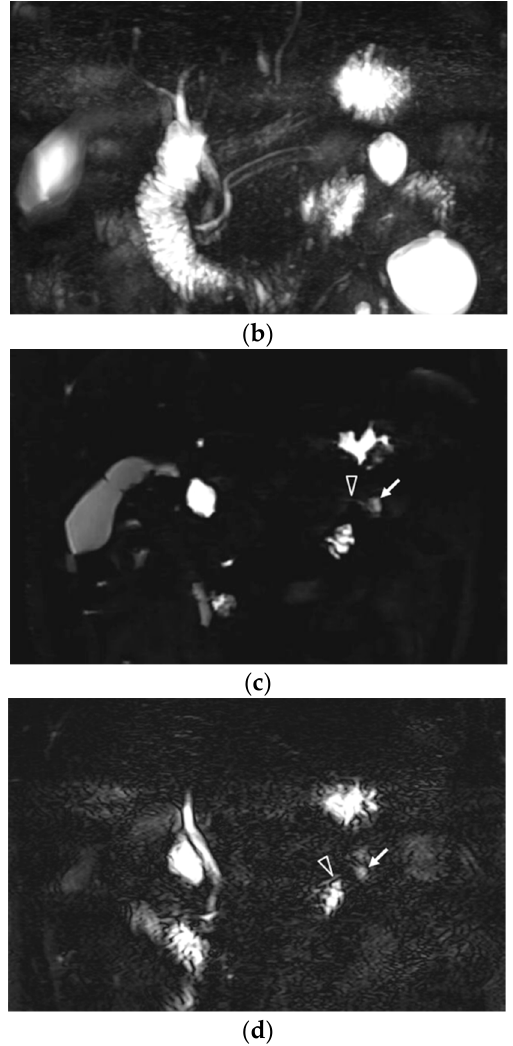
Figure 2. A 59-year-old male with a 2.4 cm sized branch-duct type intraductal papillary mucinous neoplasm (BD-IPMN) in the tail portion. Overall image quality (2 vs. 4, conventional MRCP vs. optimized BH-CS-MRCP, respectively), image degradation by artifacts (3 vs. 5), and background suppression (3 vs. 4) were all better with optimized BH-CS-MRCP ( a ) than those with conventional MRCP ( b ). BD-IPMN (arrow) is more clearly visualized on optimized BH-CS-MRCP, and the presence of communication with pancreatic duct (hollow arrowhead) was well visualized on the source image of optimized BH-CS-MRCP ( c ), while on the source image of conventional MRCP ( d ), the communication could not be seen.